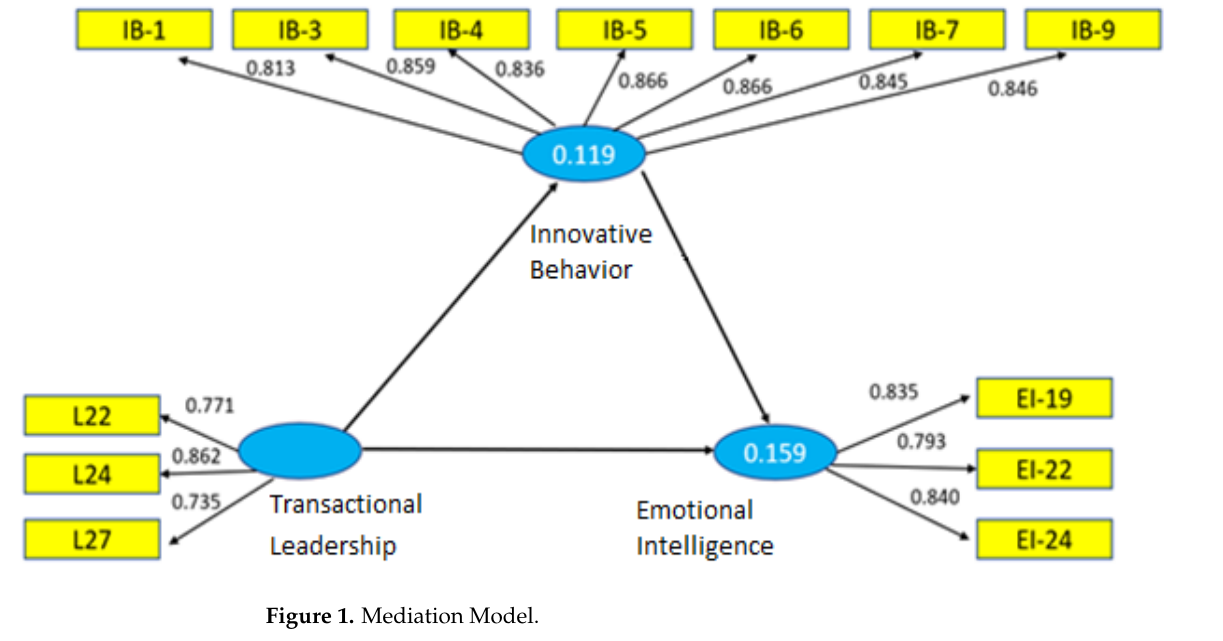
Table 3. Path coefficients and bootstrapping results.